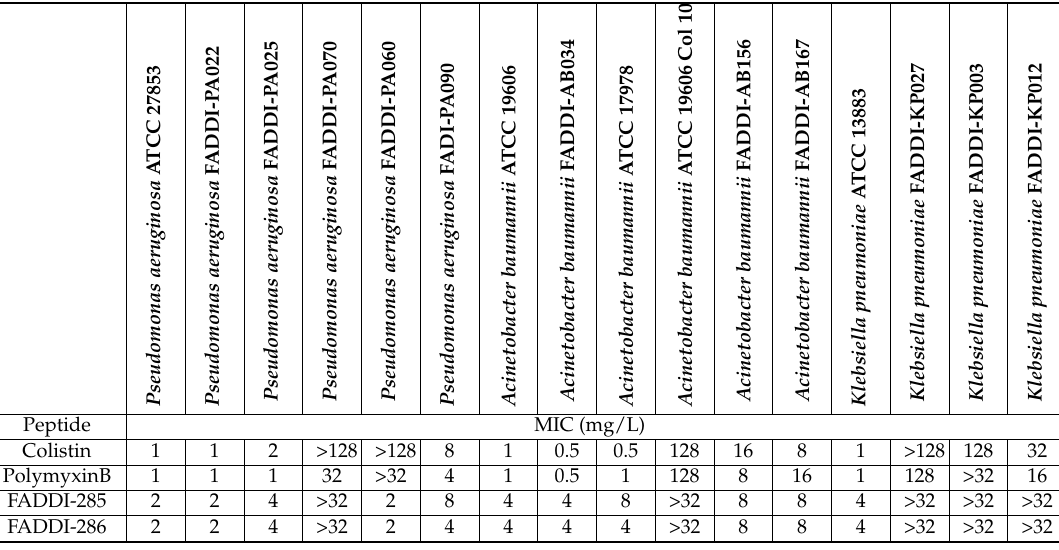
Table 1. Minimum inhibitory concentrations (MICs) of each dansylated probe, polymyxin B and colistin against Gram-negative bacteria.